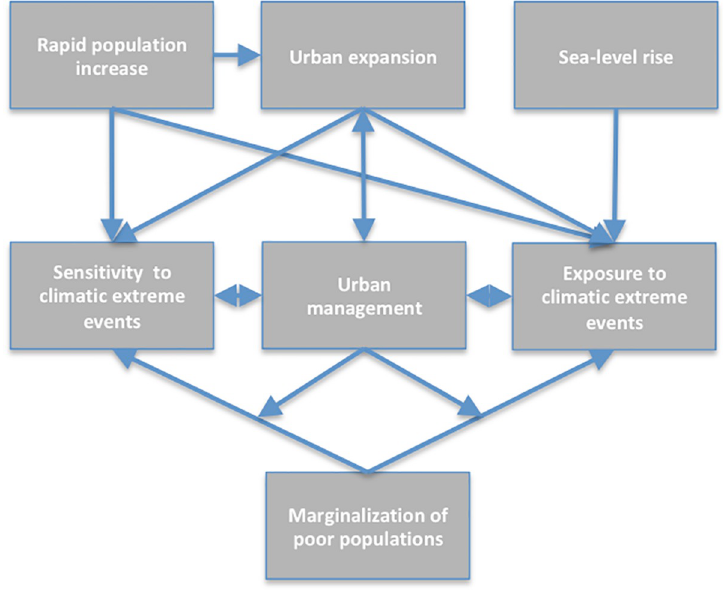
Fig 1. Key determinants and their interactions, describing socio-ecological vulnerability under rapid coastal urbanization. Arrows indicate the direction of influence.